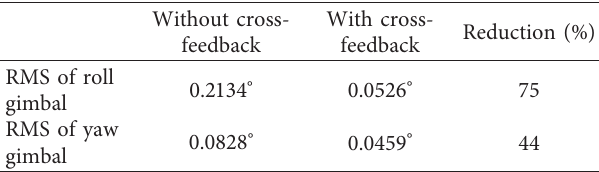
Table 4: Attitude stabilization precision of roll and yaw gimbal with dynamic base plate. Without cross- With feedback